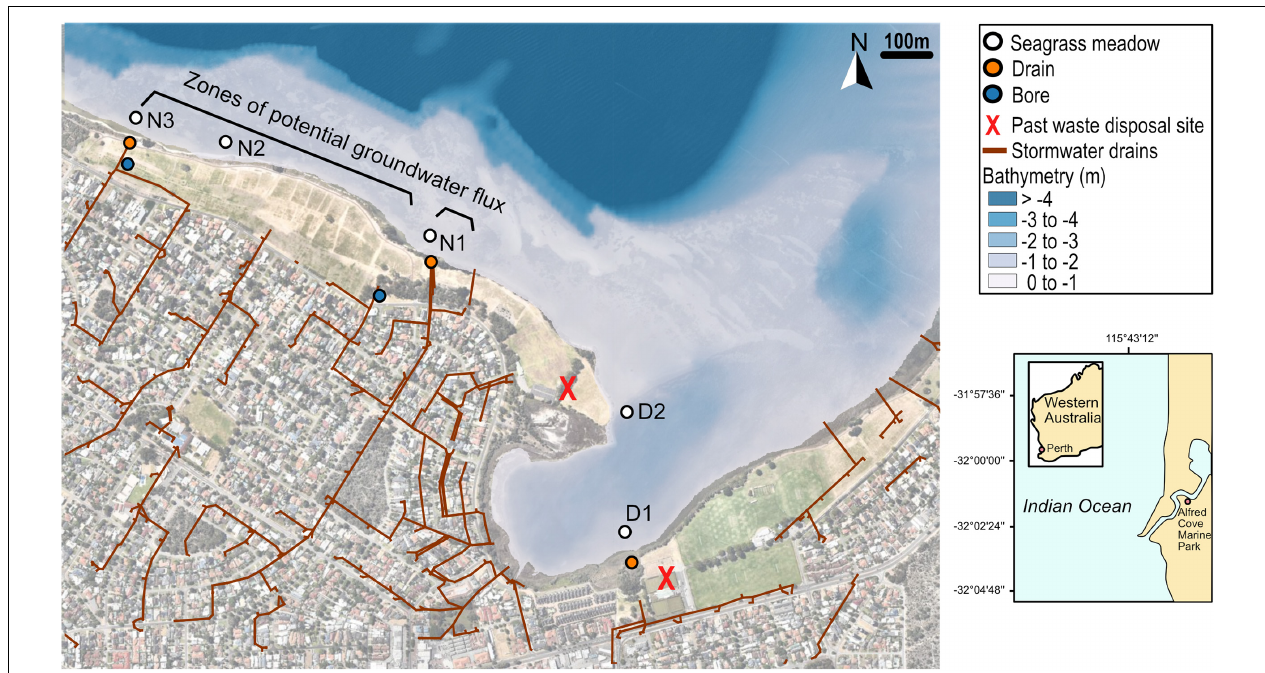
FIGURE 1 | Site names and locations along the Alfred Cove Marine Park with stormwater drainage channels, bathymetry and aerial imagery overlain, where D1 and D2 are closest to old waste disposal sites and N1, N2, and N3 are in the line of the modeled zone of groundwater flux potential. Zones of flux potential of groundwater throughflow have been adapted from Cahill et al. (2017), which were estimated from conductivity-depth profiles. Two historical domestic and building waste disposal sites which were operating in the 1950’s are marked with red crosses. Underlying map imagery © 2022 Google, Imagery © 2022 CNES/ Airbus, Maxar